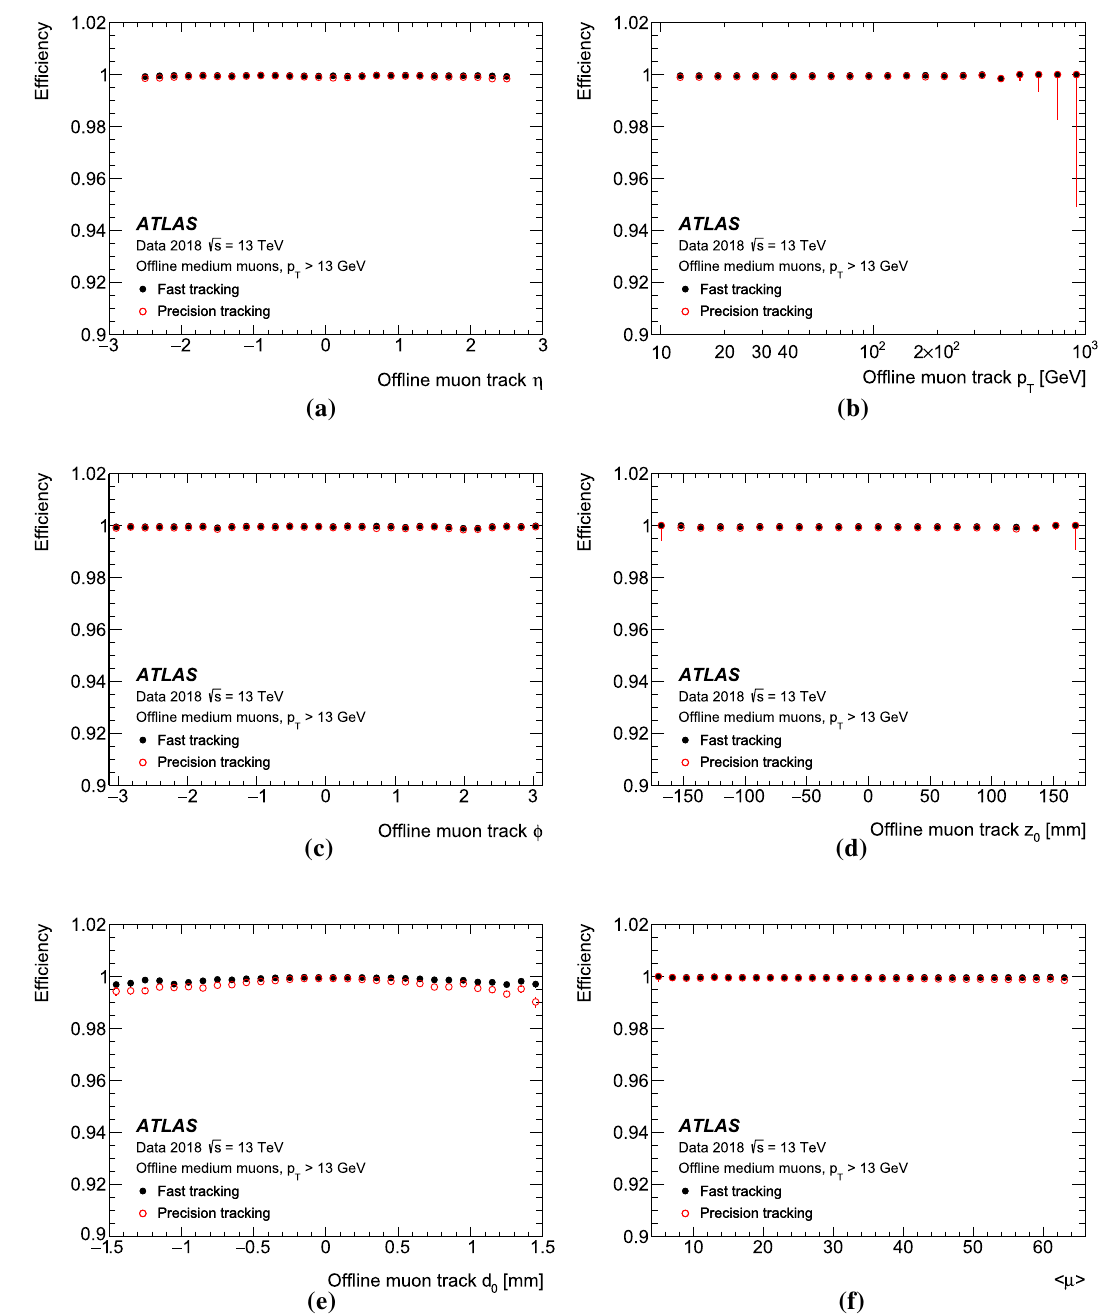
Fig. 21 The muon track finding efficiency versus a the offline muon track pseudorapidity, b the offline muon track transverse momentum, c the offline muon track azimuthal angle, d the offline muon track z 0 position along the beam line, e the offline muon track transverse impact